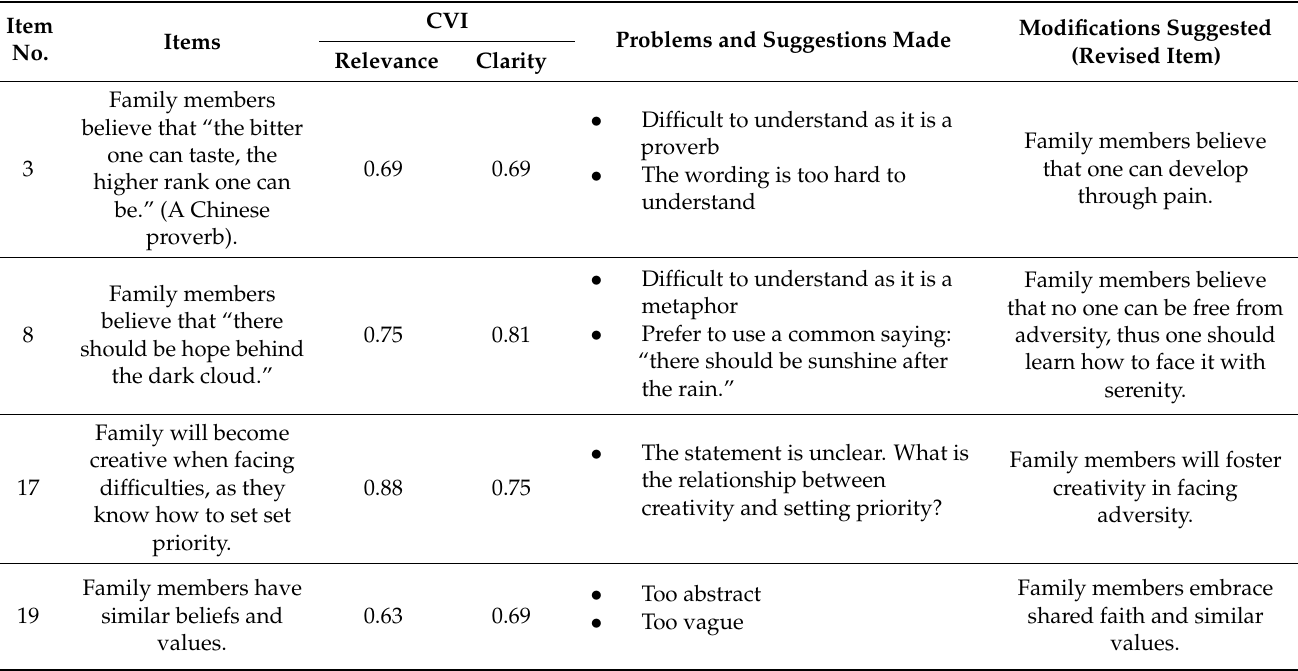
Table 1. Modification of Items on the Chinese Family Resilience Scale (only those with modification are